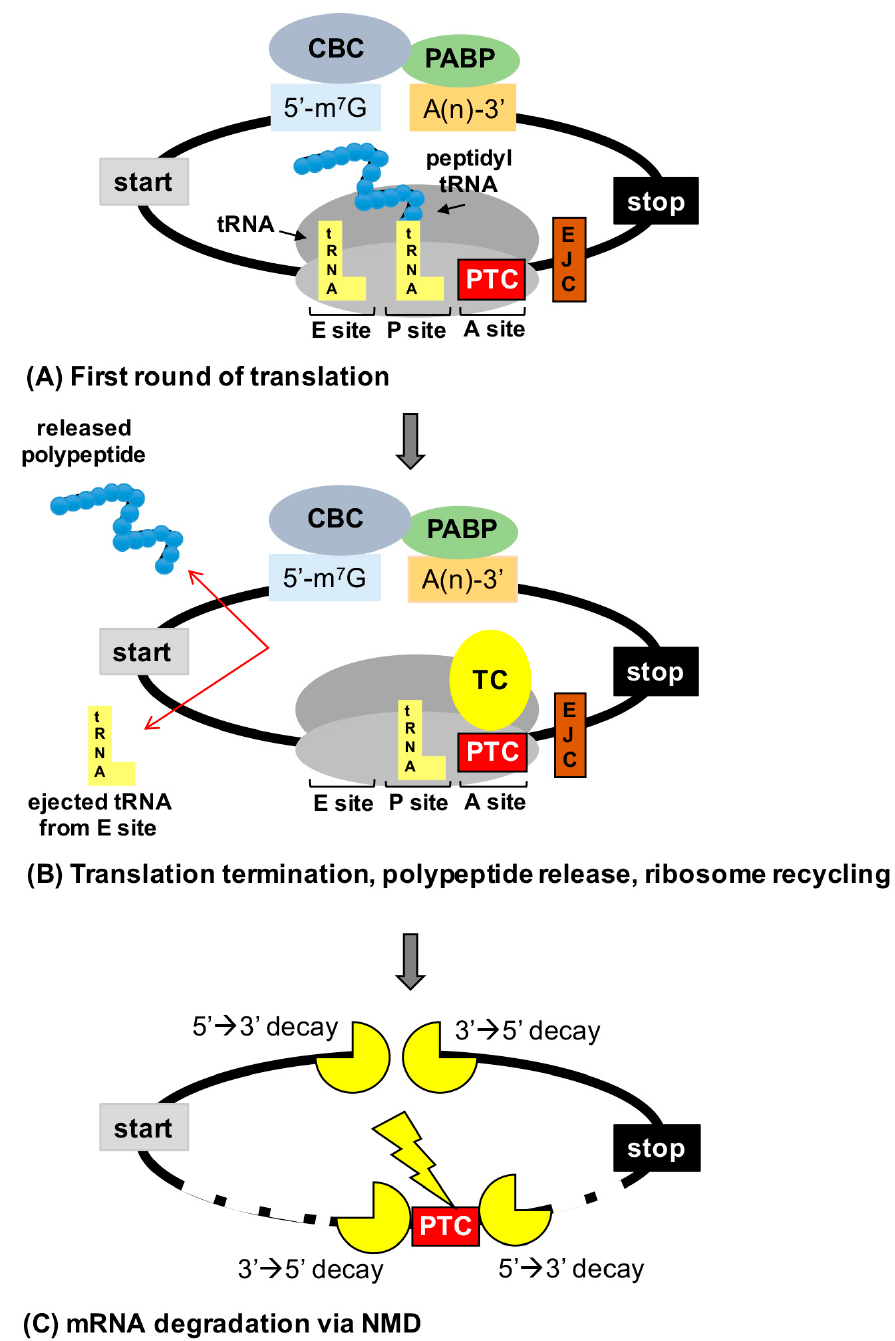
Figure 1. Consequences of premature termination codons (PTCs) on gene expression. ( A ) mRNAs are evaluated during the initial or “pioneer” round of translation for PTCs. mRNAs form a circular structure due to interactions between factors associated with the cap binding complex (CBC) and poly (A) binding protein (PABP). ( B ) Recognition of a PTC in the ribosomal acceptor (A) site by the termination complex (TC) leads to termination of translation before a full-length polypeptide is generated. ( C ) PTCs that lay 50–55 nucleotides upstream of an exon junction complex (EJC) are recognized by nonsense-mediated mRNA decay (NMD) factors that recruit the mRNA decay machinery to degrade the mRNA (either via the action of an endonuclease followed by degradation or by direct recruitment of decay factors to the 5 ′ or 3 ′ ends of the mRNA), preventing the mRNA from undergoing subsequent rounds of translation. A site = acceptor site, P site = peptidyl site, and E site = exit site.